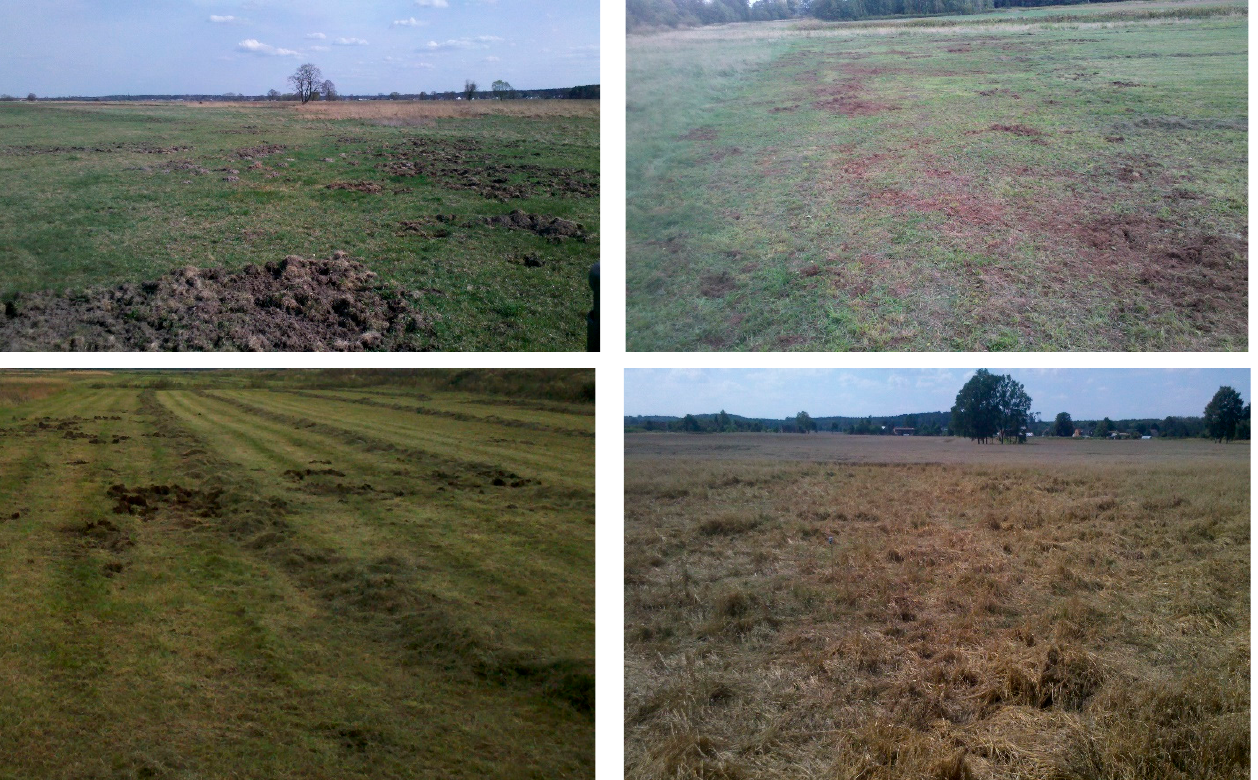
Figure 1. Examples of damages caused by wild boars (photo: Aleksandra Kuka).